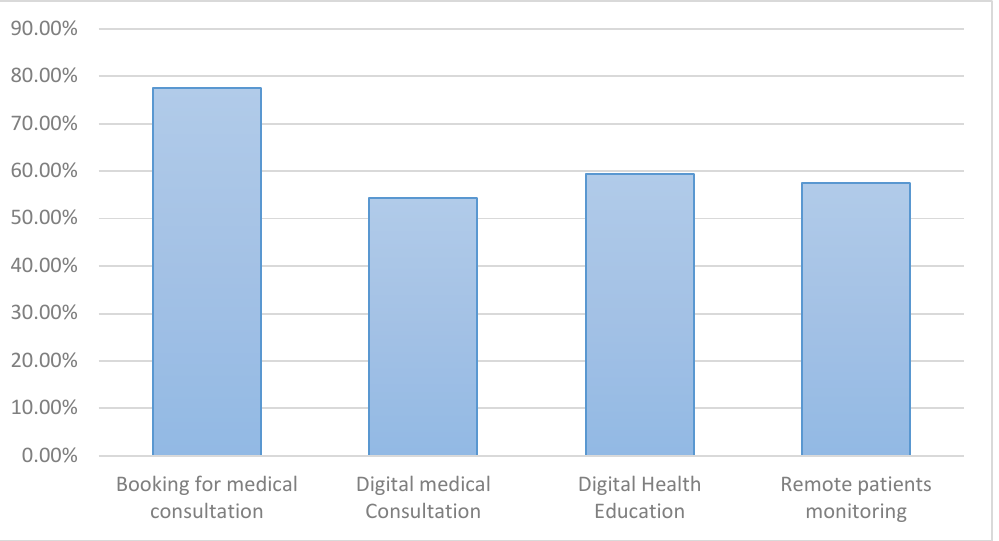
Figure 1: Preferred digital health services by the respondents